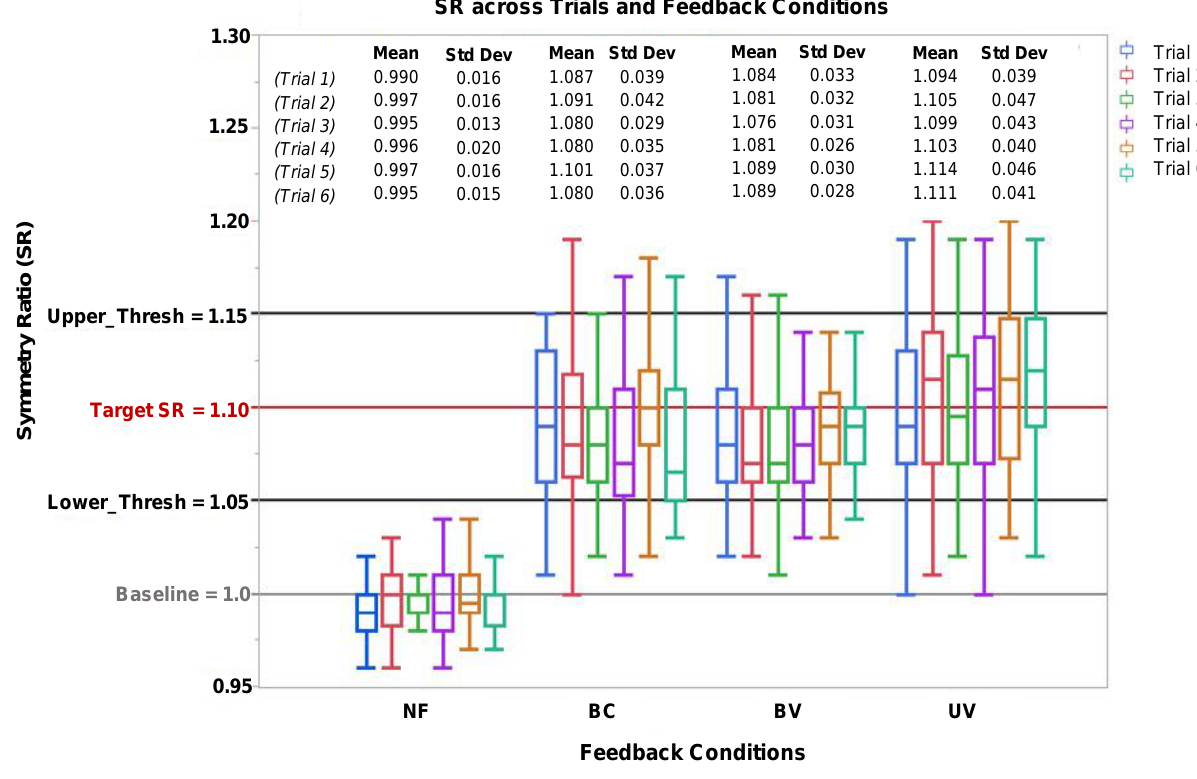
Figure 8: Learning Effects. Box plot of SR values for mean SR values of all participants across trials during No Feedback (NF) and Feedback conditions (BC, BV, UV). BC: Bidirectional control – constant vibration; BV: Bidirectional control – variable vibration; UV: Unidirectional control – variable vibration. No statistically significant differences were found among conditions. Mean and standard deviations (Std Dev) are also included above for each trial. Upper and Lower Thresholds labeled as Upper_Thresh and Lower_Thresh, respectively.